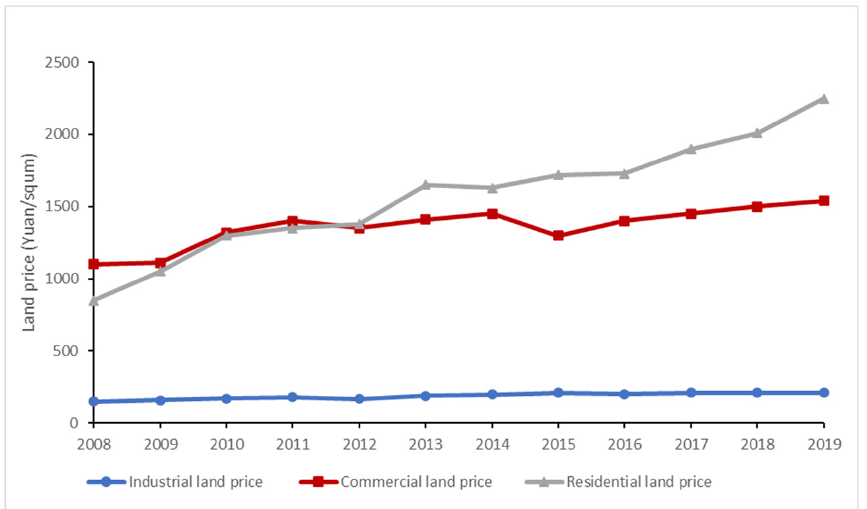
Figure 4. Changes in land prices with different land